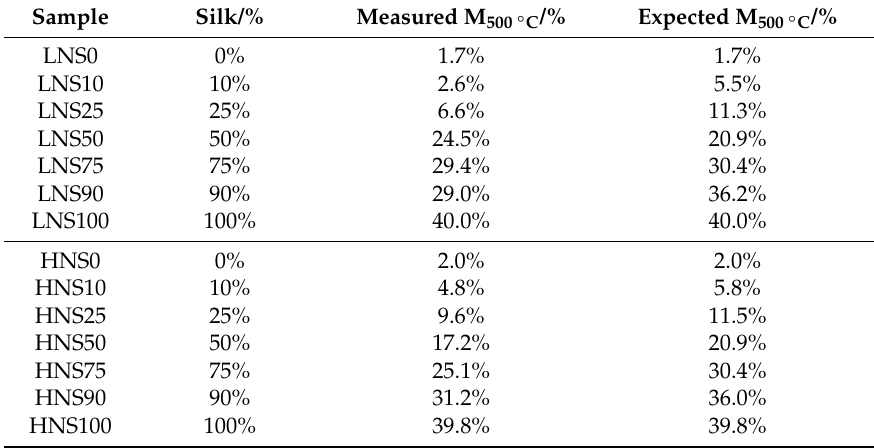
Table 1. Thermogravimetric analysis (TGA) results showing measured vs. expected values for mass remaining at 500 ◦